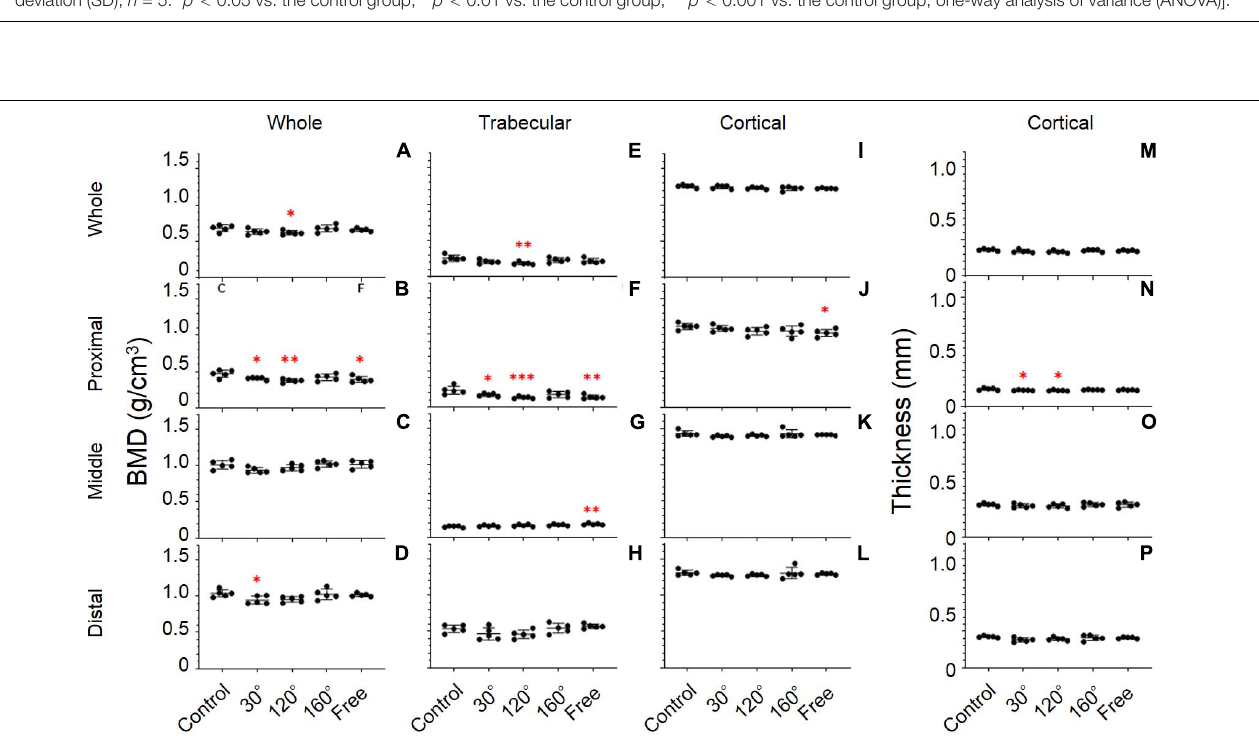
FIGURE 6 | Tibial bone parameters. The bone parameters of different tibial areas of the five tested groups are shown. (A–D) BMD, (E–H) trabecular BMD, (I–L) cortical BMD, and (M–P) cortical thickness. (A,E,I,M) Whole tibia, (B,F,J,N) proximal tibia, (C,G,K,O) middle tibia, and (D,H,L,P) distal tibia [Mean ± standard deviation (SD), n = 5. * p < 0.05 vs. the control group, ** p < 0.01 vs. the control group, *** p < 0.001 vs. the control group, one-way analysis of variance (ANOVA)].